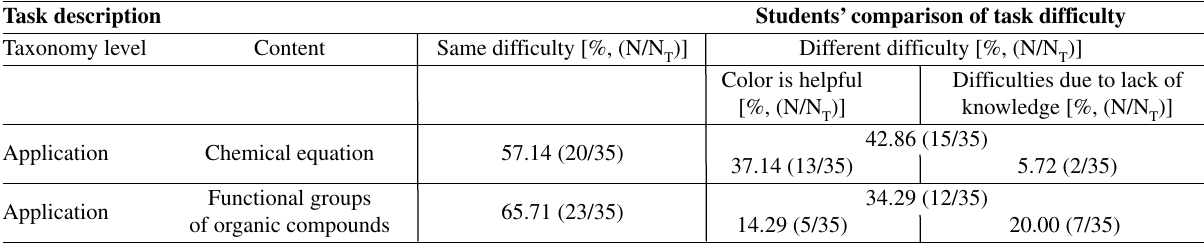
Table 4. Analysis of students’opinions about solving tasks in Section 1 Task description